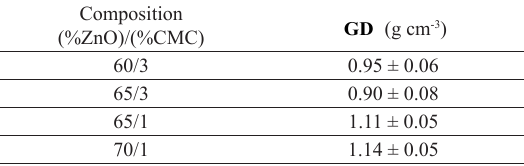
Table 2. Green density (GD) for 60/3, 65/1, 65/3, and 70/1 compositions calculated according to Equation (1).